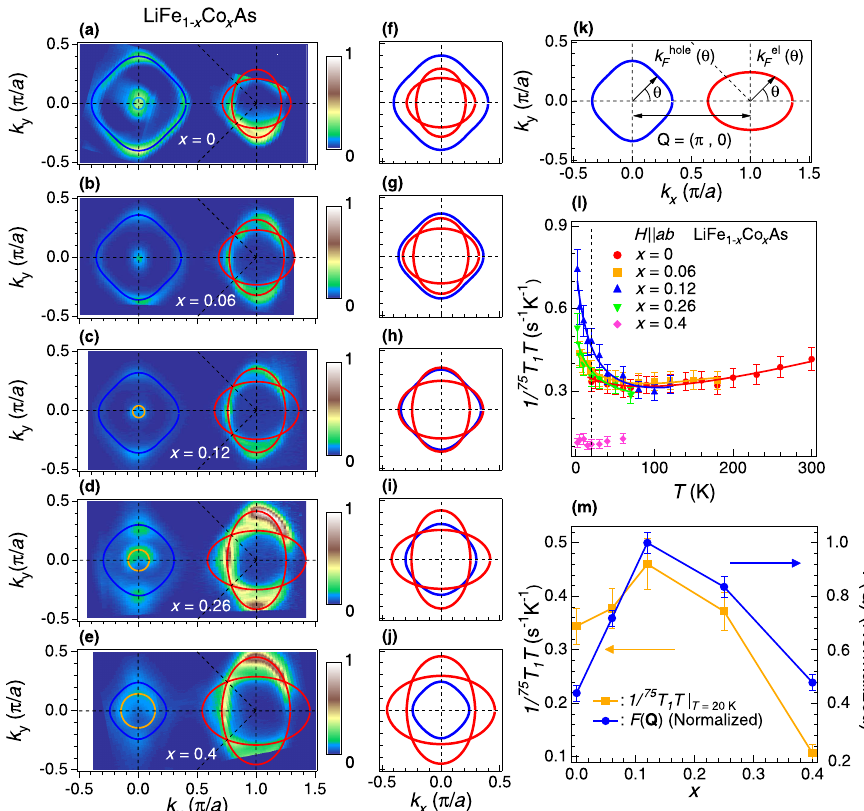
FIG. 3. (a) – (e) FS contour of LiFe 1 − x Co x As for five representative Co concentrations, determined by integrating the ARPES spectral intensity within (cid:2) 10 meV with respect to E F . (f) – (j) Extracted FSs from corresponding ARPES measurements for each doping. (k) Definition of k hole F ð θ Þ , k el F ð θ Þ , and Q in the k space. (l) Spin-lattice relaxation rate 75 As 1 =T 1 T as a function of temperature for five Co concentrations measured by NMR. (m) Evolution of 75 As 1 =T 1 T at 20 K (solid squares) and FS nesting factor (solid circles) with increasing Co